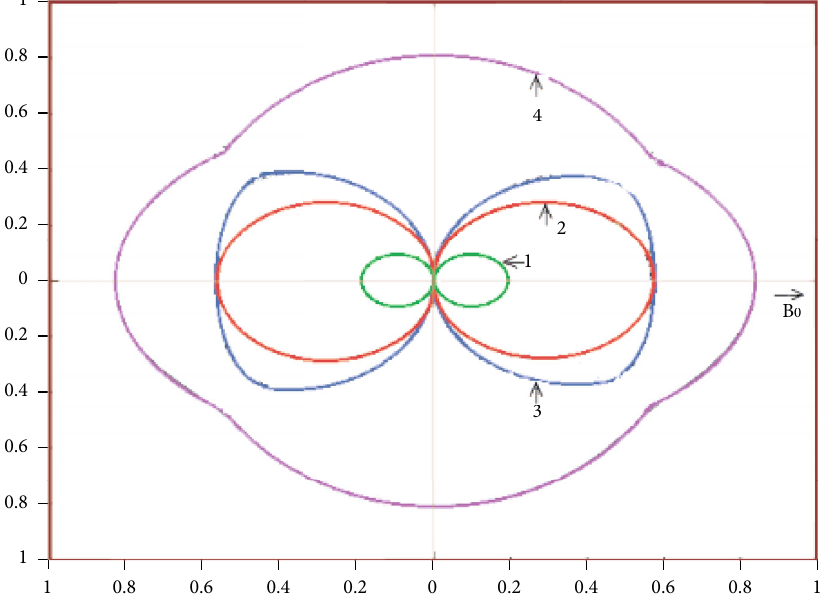
Figure 4: Polar plots of the phase speeds of all the four modes for relativistic anisotropic magnetohydrodynamics two-component plasma using M 2 A = 0 : 9, b 2 ⊥ = b 2 ∥ = 0 : 5, b 2 ⊥ = b 2 ∥ = 0 : 0125 , and d = 10 1 1 2 2